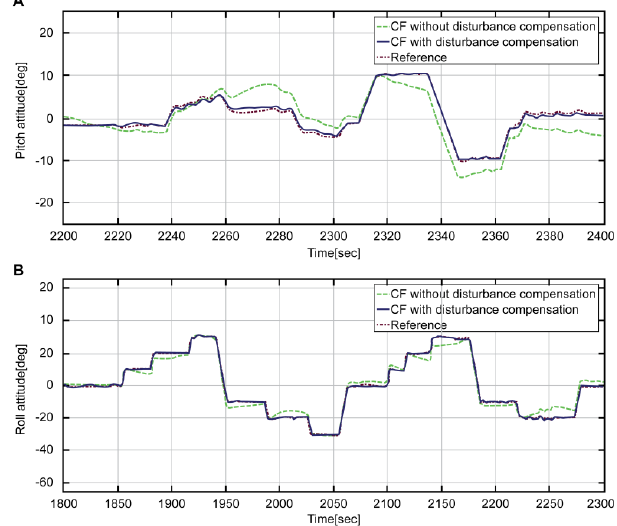
Figure 11. Attitude maneuver section by each complementary filter and Reference attitude; A: Pitch attitude, B: Roll attitude.